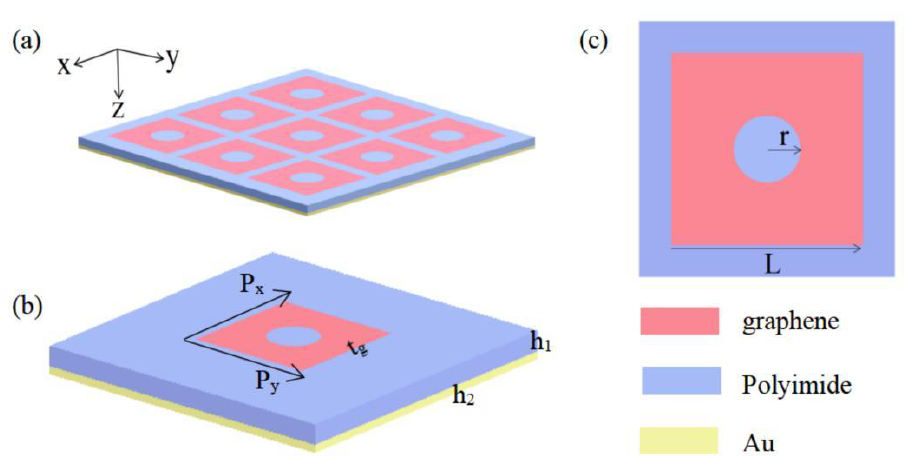
Figure 1. Structure of the proposed absorber. ( a ) Schematic view; ( b ) unit cell; ( c ) top view (x-y plane). The structural parameters of the proposed absorber are listed in Table 1. The conduc- tivity of the bottom gold plate is σ = 4.56 × 10 7 S/m. The loss of polyimide is very low at the terahertz frequency, and its relative dielectric constant is about 2.4. Table 1. Structural parameters of the proposed absorber.